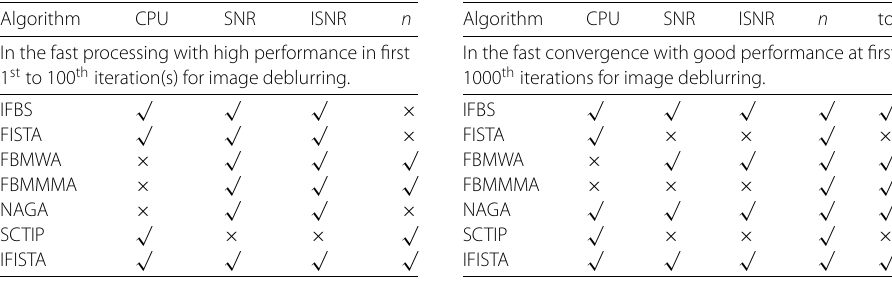
Table 4 The effectiveness comparison of image deblurring